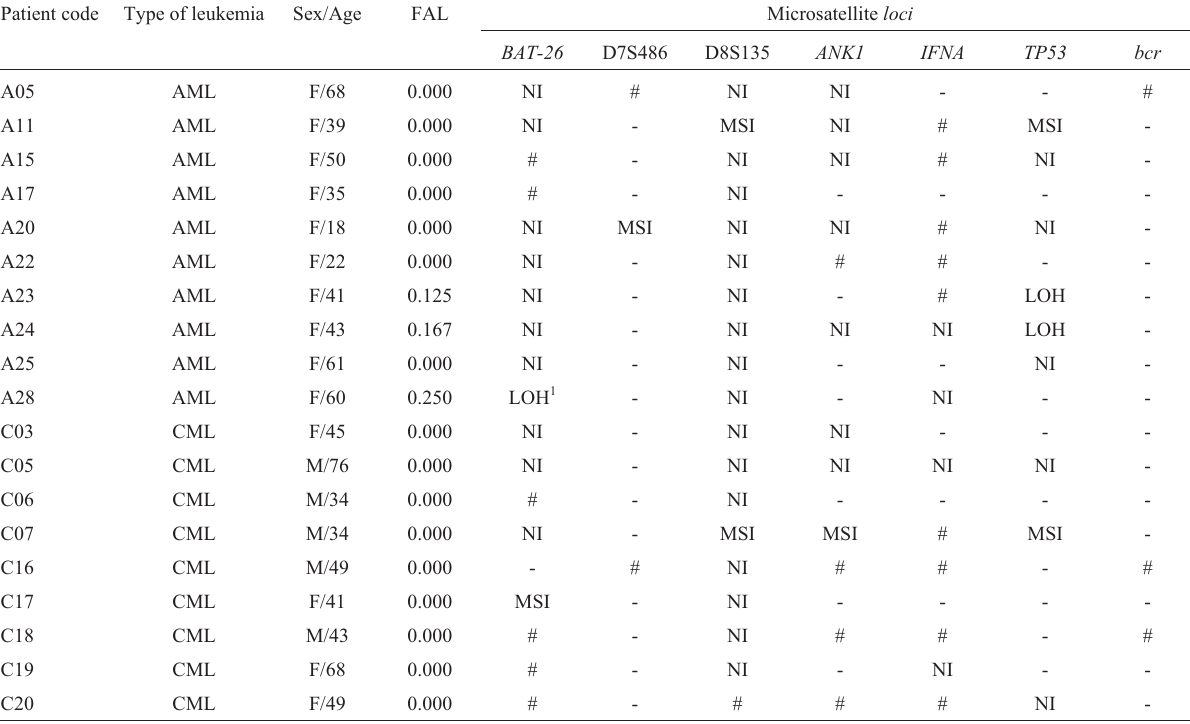
Table 2 - Analysis of MSI and LOH in AML and CML patients. Patient code Type of